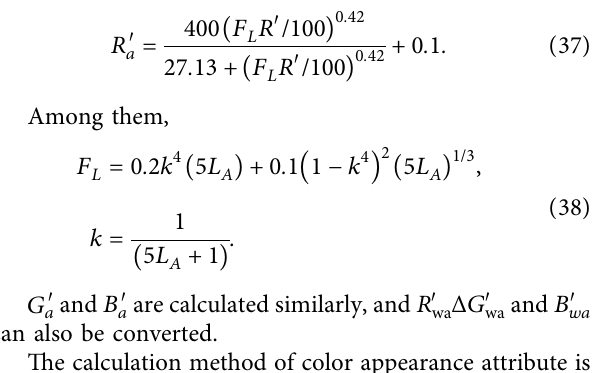
Figure 5: The relationship of D − L